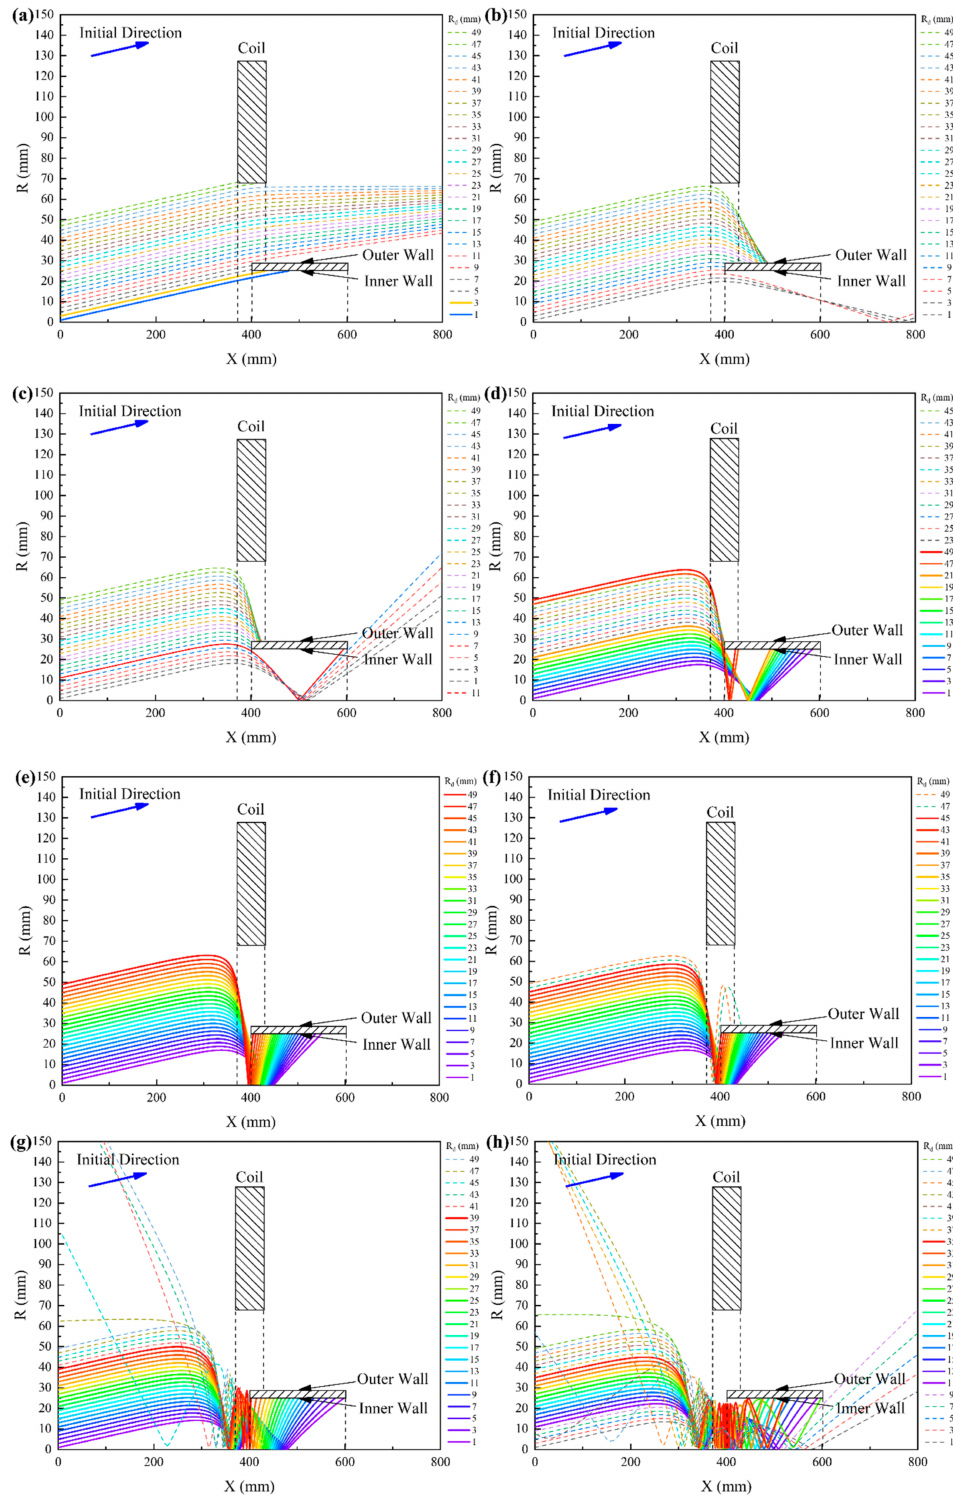
Figure 10. Trajectories of ions with emission angle of 3 ◦ under characteristic magnetic flux densities: ( a ) 230 Gs; ( b ) 690 Gs; ( c ) 1092 Gs; ( d ) 1380 Gs; ( e ) 1610 Gs; ( f ) 1840 Gs; ( g ) 3450 Gs; ( h ) 4600 Gs. With a further increase in the characteristic magnetic flux density, the ions turned to form a continual trajectory, with fewer ions blocked by the pipe (Figure 10e,f). As the characteristic magnetic flux density increased to 1610 Gs, the number of deposited ions reached a maximum value.